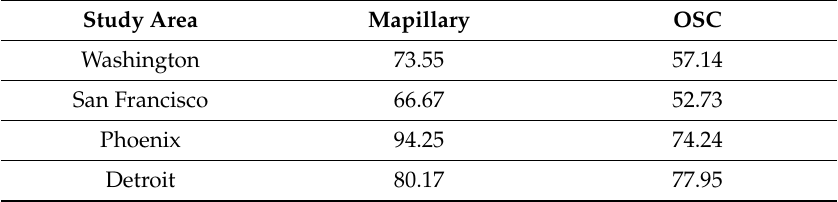
Table 5. Percentage of 1 × 1 km grid cells mapped more than once by the same